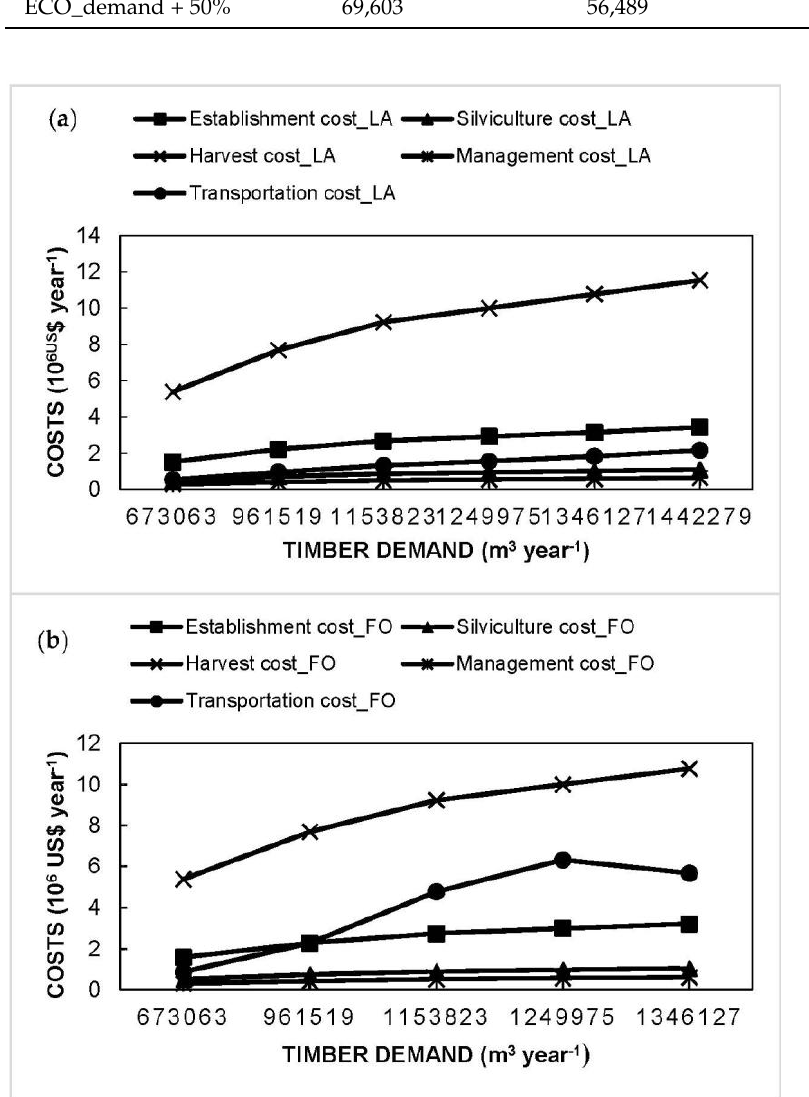
Figure 6. Change in cost components under the landscape approach ( a ) and the current forest ap proach ( b ) for different timber demands according to variations in timber demand. approach ( b ) for different timber demands according to variations in timber